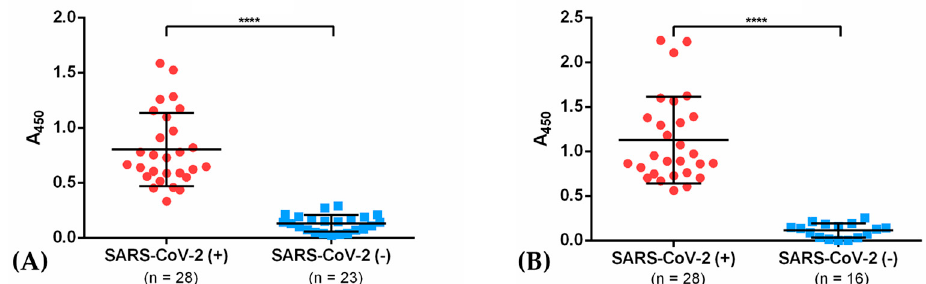
Figure 5. IgG response in SARS-CoV-2 positive patients and healthy subjects against the recombinant antigens NG06 ( A ) and NG19 ( B ). Data are presented as the mean of the triplicate OD values per subject. Each dot represents one subject and horizontal bars correspond to the mean values with SD. **** indicates a significance level of p < 0.0001.